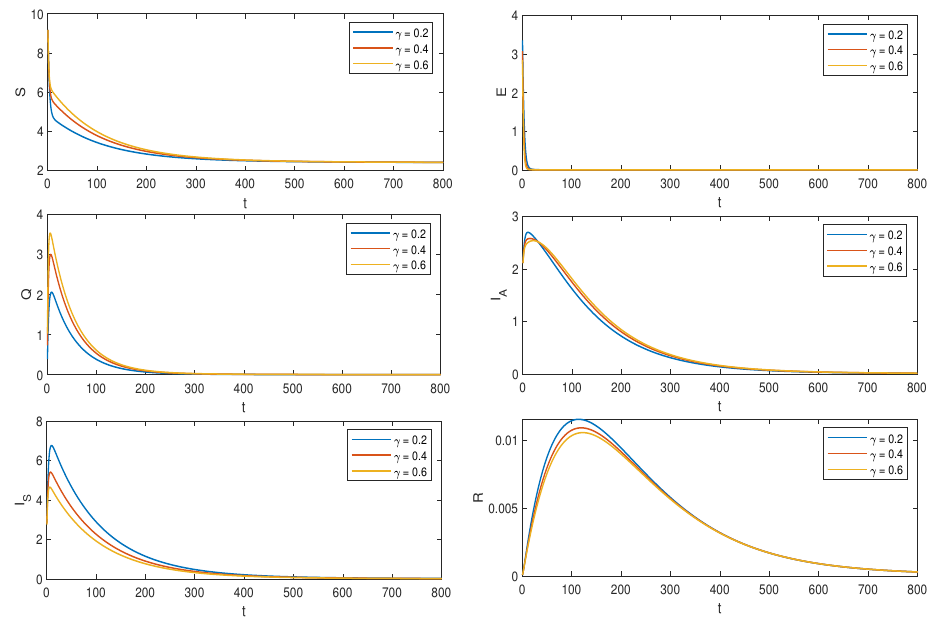
Figure 5. The effect of parameter γ on the